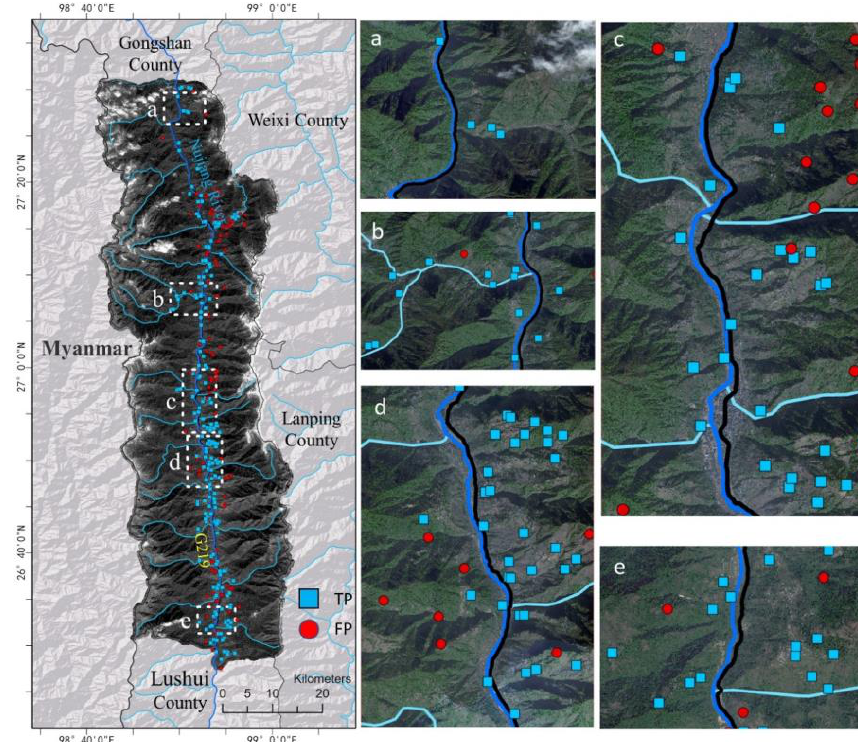
Figure 8. The possible landslides detected by Yolo. Here, TP is the intersection of Yolo results and references, while FP indicates those not recorded in the reference inventory. Panel ( a – e ) are used to display specific regions of the left panel more clearly.